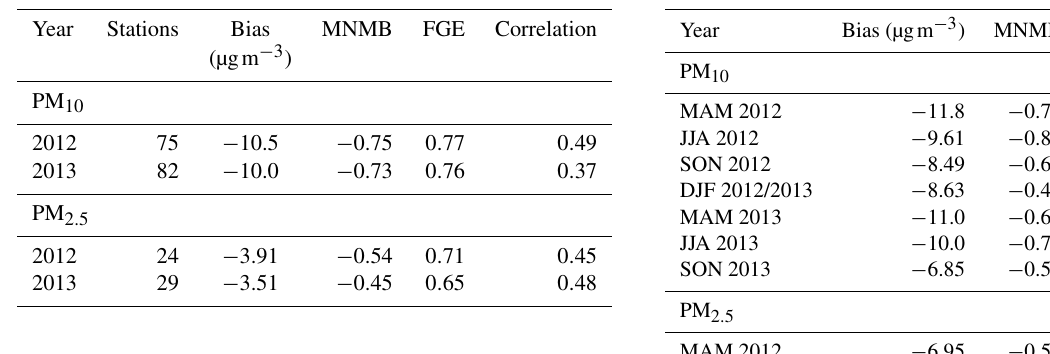
Table 6. Statistics of the comparison between the MOCAGE sim- ulation and the AQeR database measurements, corresponding to classes 1 to 5 from the classification of Joly and Peuch (2012) for the years 2012 and 2013 on the budget domain. The table presents results for PM 10 and PM 2 . 5 .